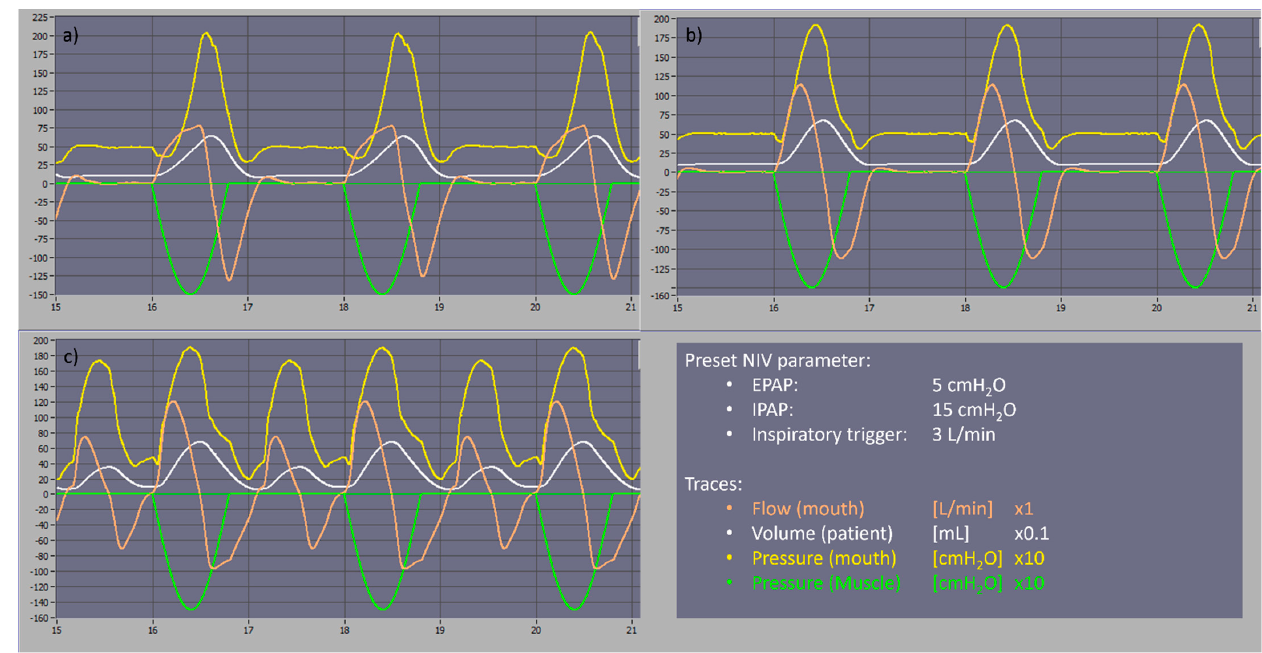
Figure 1. Asynchrony comparison in severe restrictive type scenarios between two the most common NIV devices. Keys: ( a ) COVIDair, ( b ) A40™, ( c ) Stellar™ 150, NIV: non-invasive ventilation, EPAP: expiratory positive airway pressure, IPAP: inspiratory positive airway pressure.